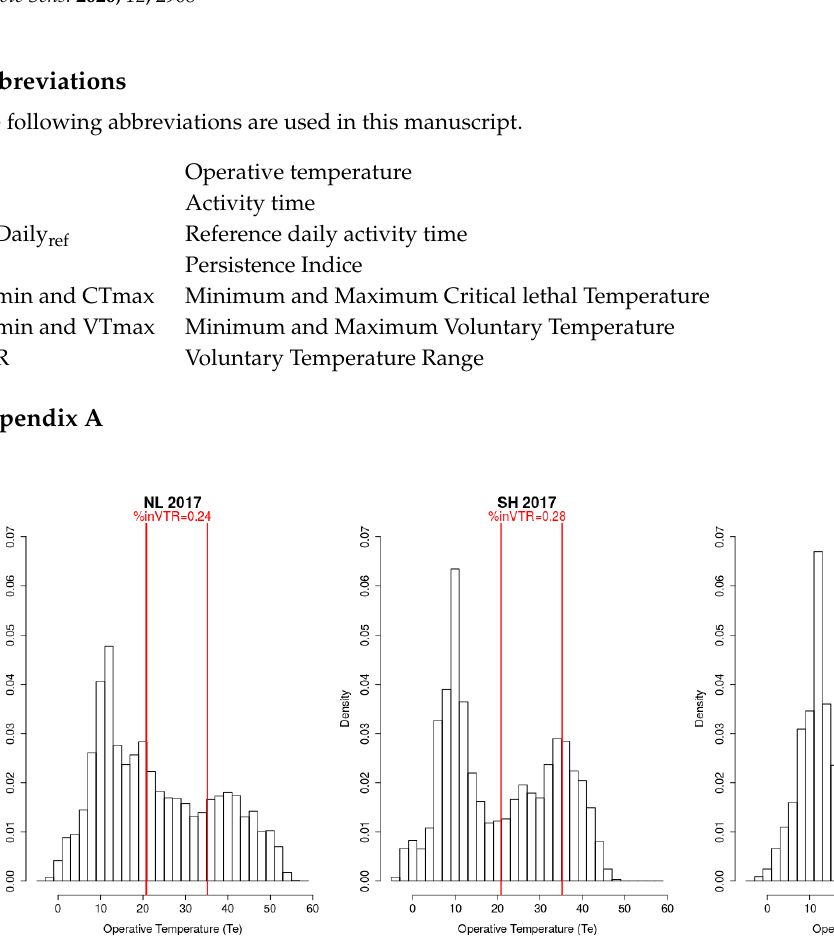
Figure A1. Operative temperatures (Te) measured over the day, defined by sunrise and sunset, over the breeding period. Percentage distribution of Te within the voluntary thermal range (VTR) also called the activity thermal